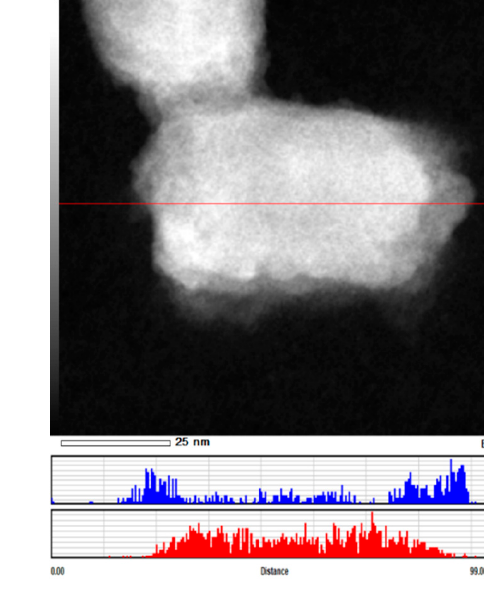
Table 2. Composition, morphological and spin crossover properties extracted from optical meas- urements for nanoparticle samples 1–18.